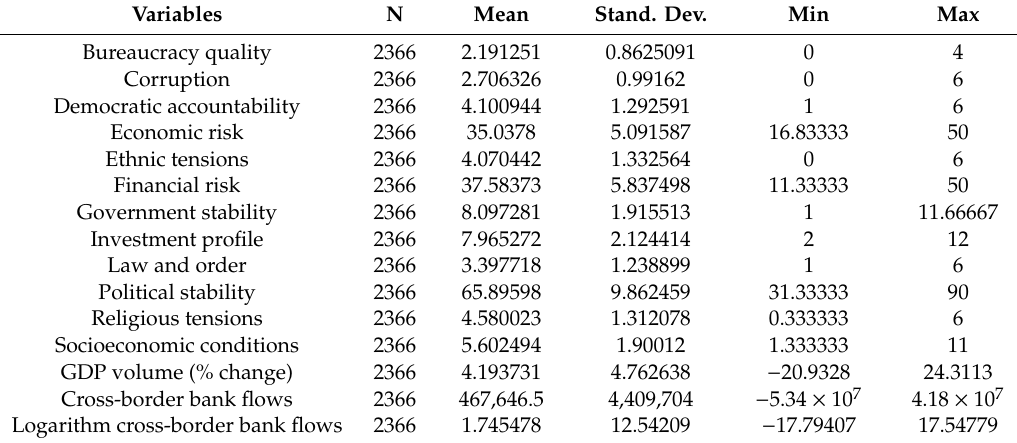
Table A3. Descriptive statistics—non-OECD